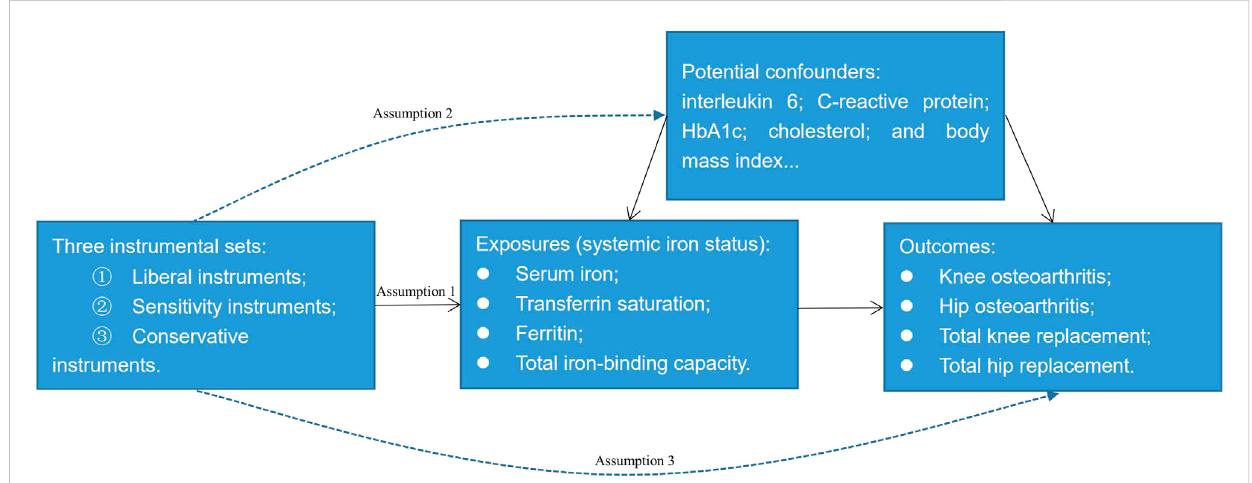
An overview of the Mendelian randomization design. Assumption 1: The instrumental variables must be strongly associated with the exposures; Assumption 2: The instrumental variables must be independent of the potential confounders of the association between the exposure and outcome; Assumption 3: The instrumental variables should not be associated with the outcomes